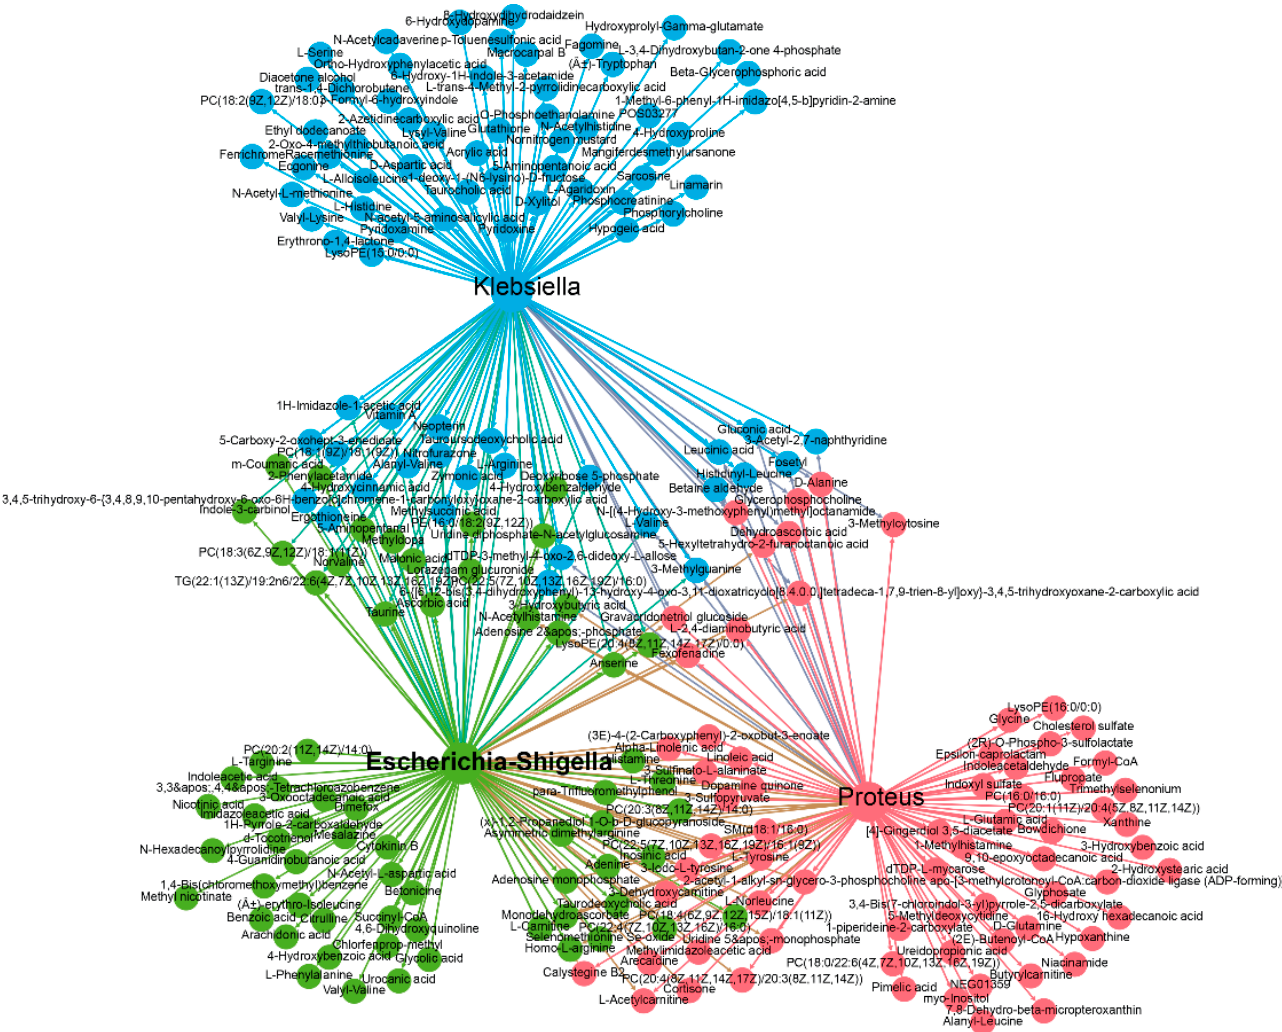
Figure 8. Correlation network between Escherichia-Shigella , Klebsiella and Proteus and differential metabolites. Different colours represent different clustering modules. NFD ( n = 4), NFDA ( n = 5).